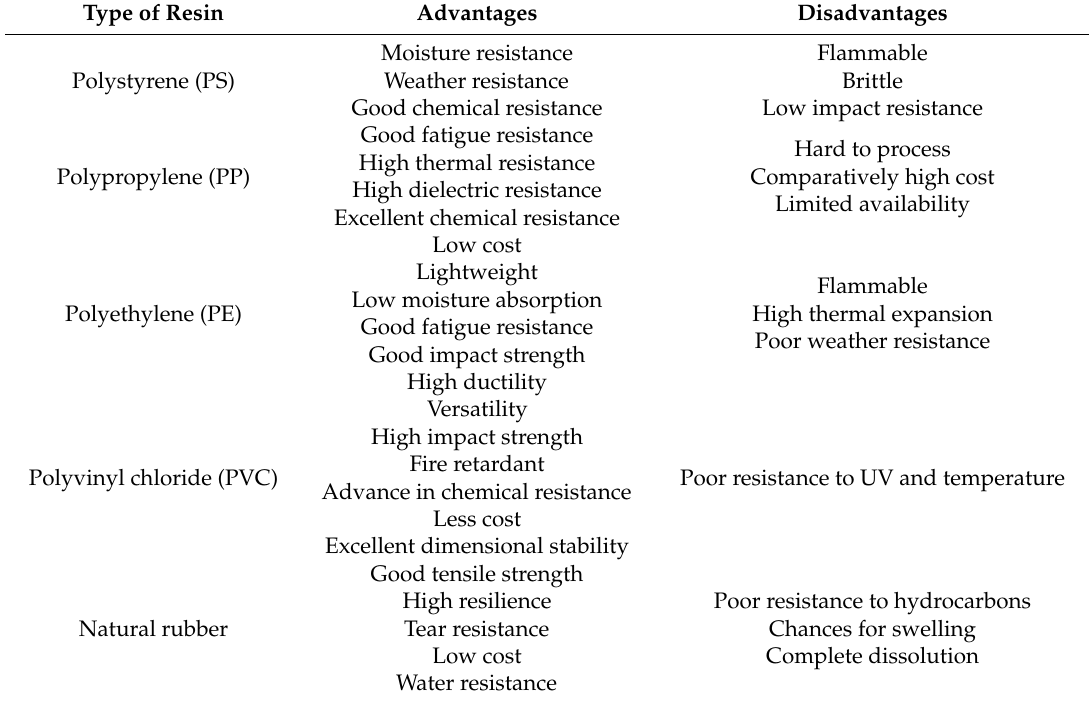
Table 7. Thermoplastic resins advantages and